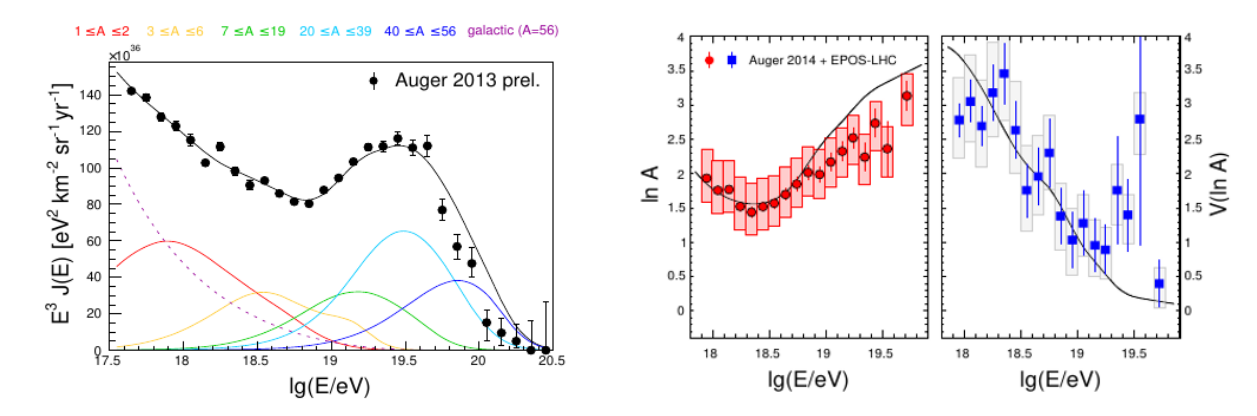
Figure 3. The energy spectrum, X max and RMS( X max ) as functions of energy for an injection composition following a Galactic mixture; from Ref.